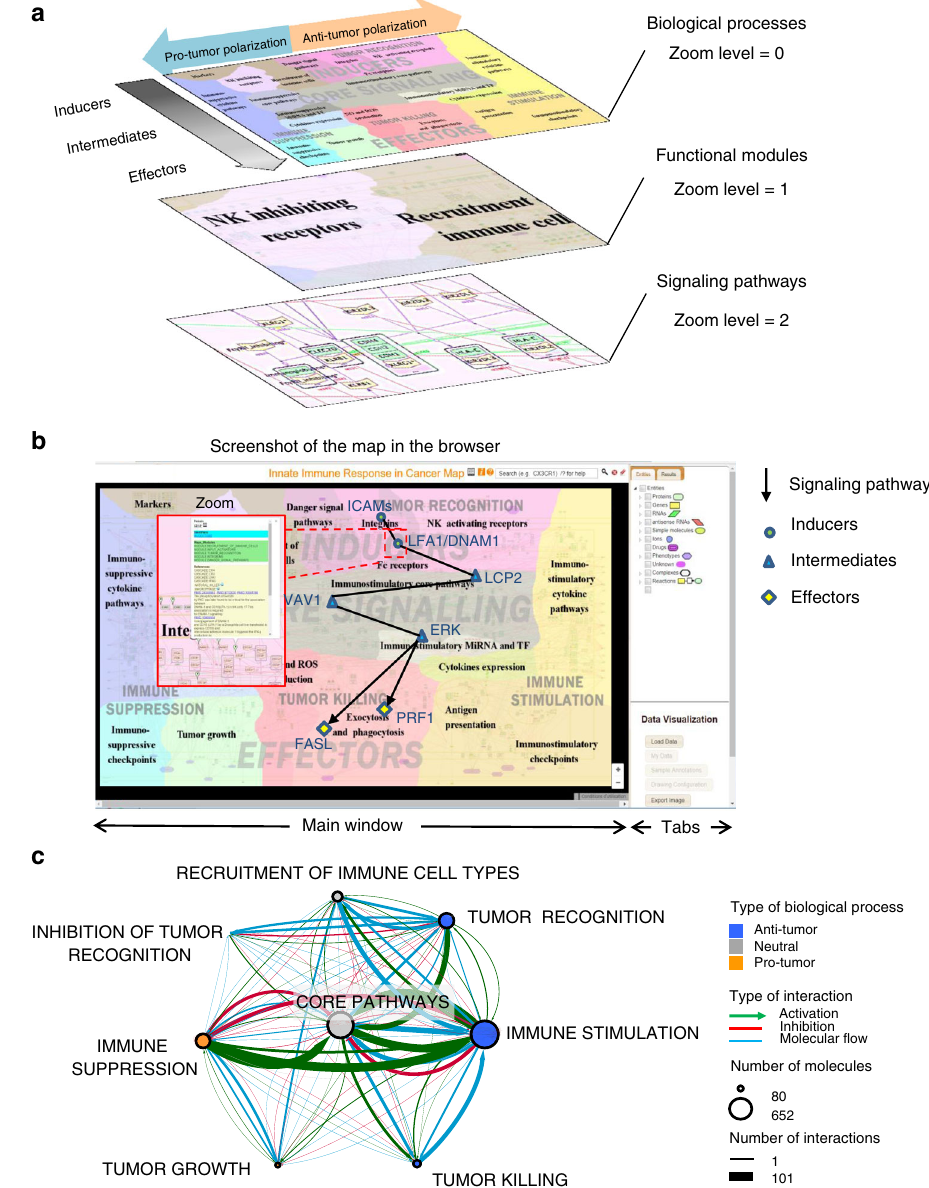
Fig. 3 Structure of meta-map of innate immune response in cancer. a Top view layout of the innate immune meta-map. Functional modules represent key processes involved in pro-tumor and anti-tumor activity of innate immunity in cancer, showed at different zoom levels (0 — polarization and biological processes, 1 — functional modules, 2 — signaling pathways, molecules, interaction types, and annotation details. b Signaling pathways in the meta-map structure in a browser window. c The network of modules demonstrating crosstalks between biological processes represented on the meta-map. Nodes represent biological processes with the size associated to number of molecules in a process, color of the node is related to pro/anti-tumor polarization (see legend), interactions re fl ect cross-talk between the biological processes, the thickness of the edge is related to number of interactions and the color to the nature of